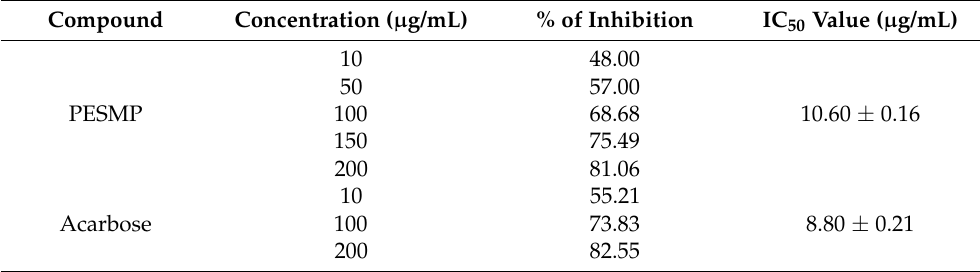
Table 5. α -Amylase inhibition findings against PESMP compound.